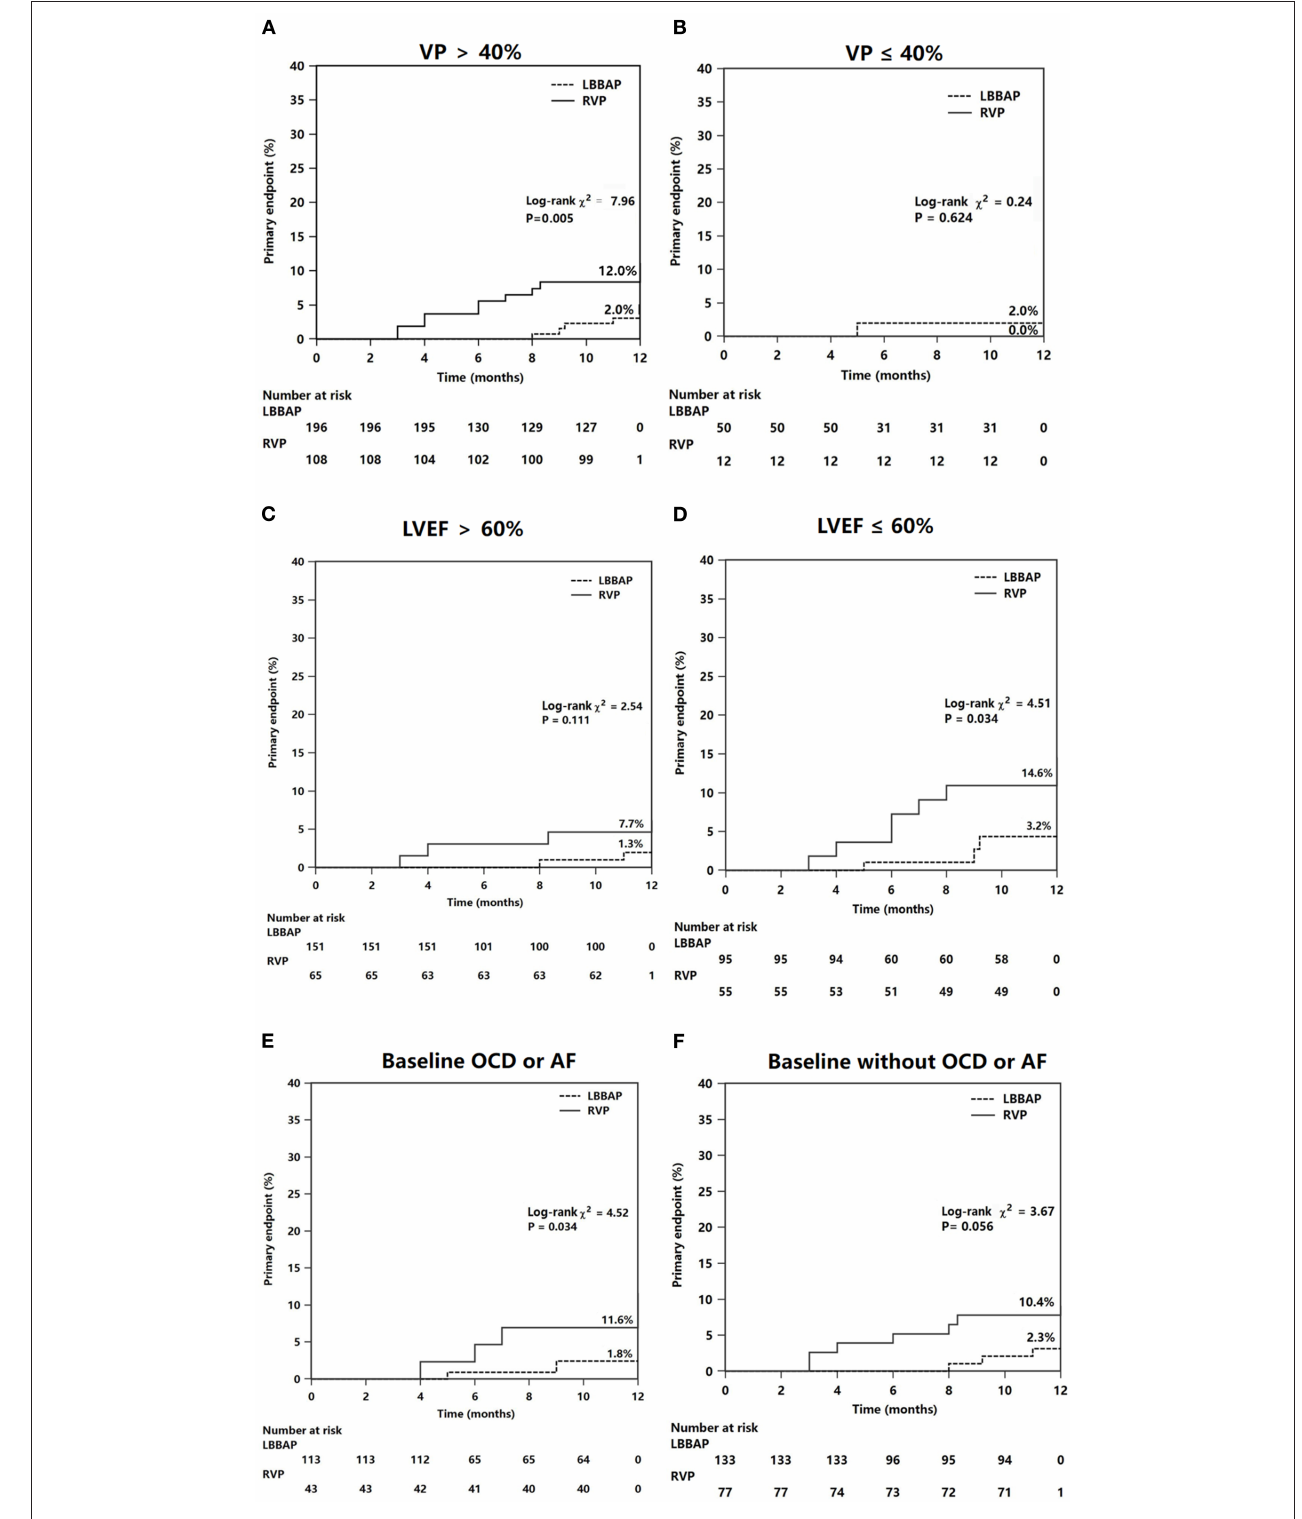
FIGURE 4 | Subgroup Kaplan–Meier survival curves and analysis of the primary endpoints. The composite heart failure events was analyzed according to different groups of VP (A,B) , LVEF (C,D) , and status of OCD or AF at baseline (E,F) . VP, ventricular pacing (percentage); OCD, organic cardiac disease; AF, atrial fibrillation.